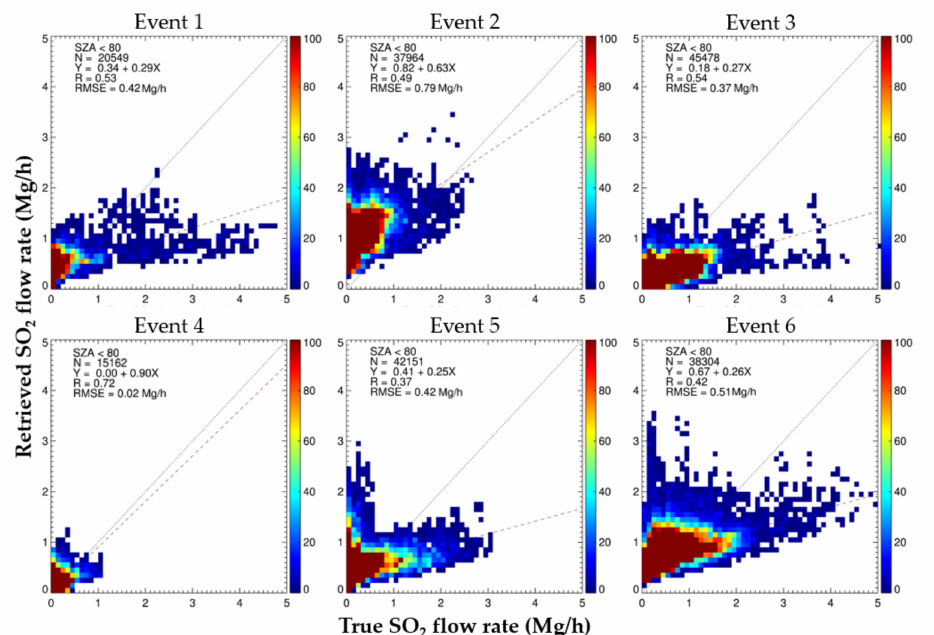
Figure 17. Correlation between true and retrieved SO 2 flow rates under the conditions of the GEMS SO 2 retrieval error with no errors in wind data for each event in Table